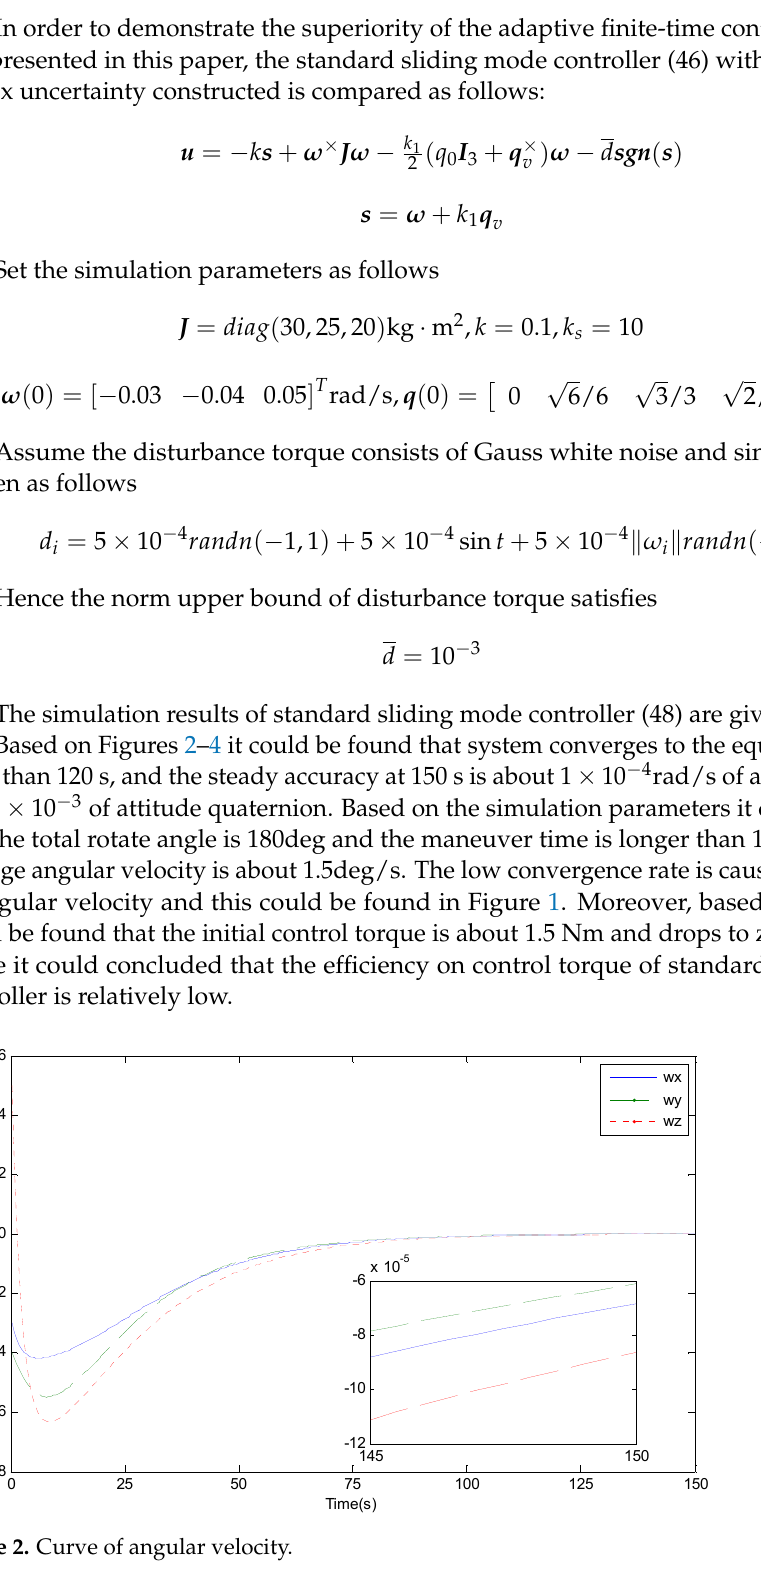
Figure 3. Curve of attitude quaternion.